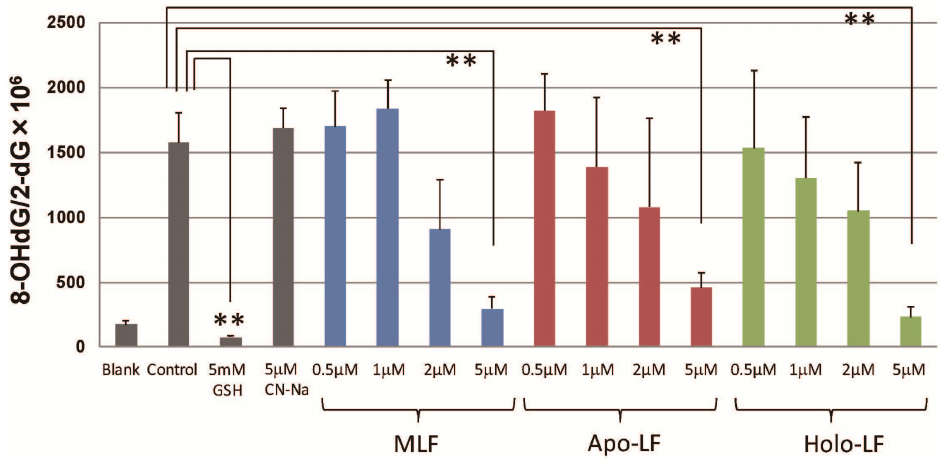
O ; lane 3, H O -treated 2 2 2 2 O ; ( B ) Densitometry of 2 2